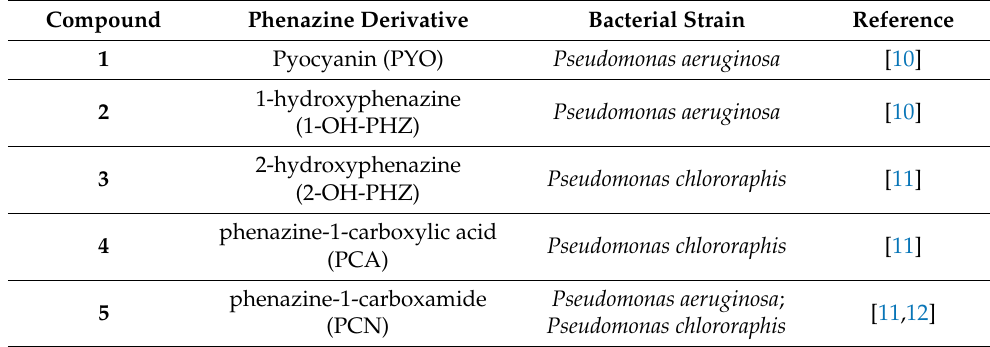
Table 1. Different phenazine derivatives associated with their producing bacterial strain. Compound Phenazine Derivative Bacterial Strain Reference 1 Pyocyanin (PYO) Pseudomonas aeruginosa [10] 1-hydroxyphenazine Pseudomonas aeruginosa (1-OH-PHZ) 2-hydroxyphenazine Pseudomonas (2-OH-PHZ)